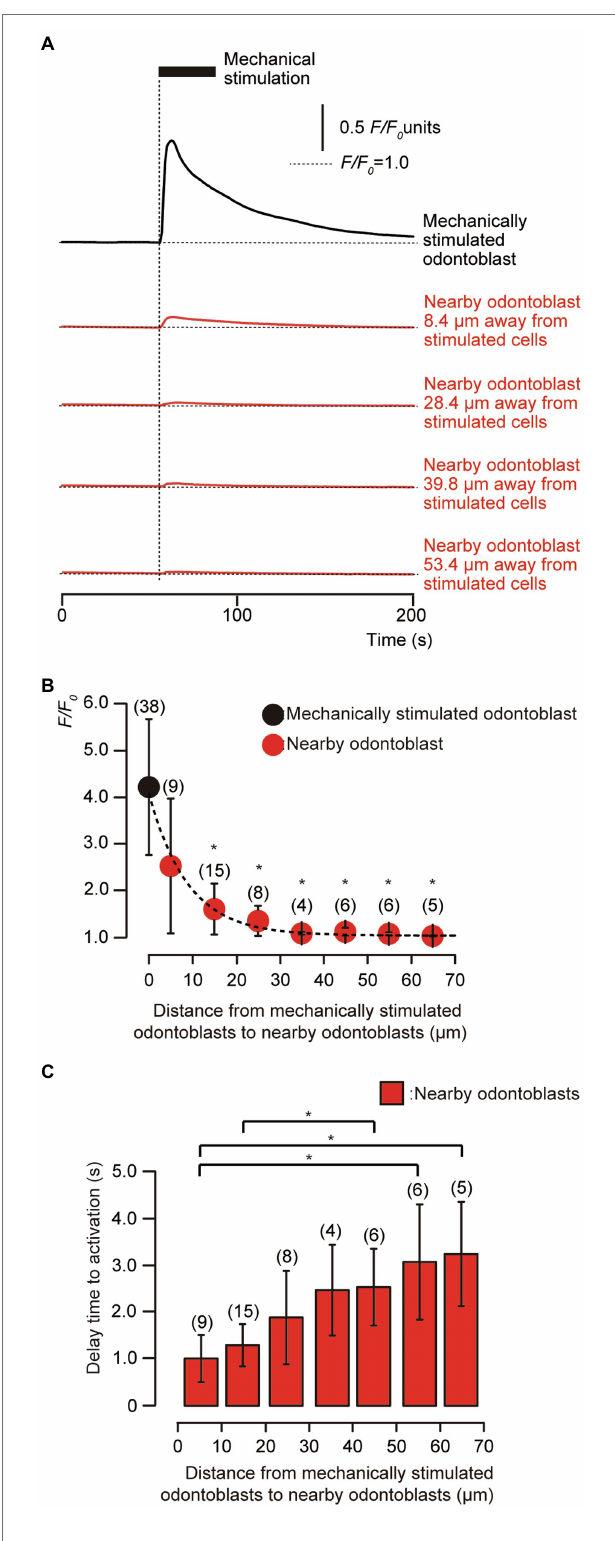
FIGURE 2 | Transient [Ca 2+ ] i increases in mechanical-stimulated human odontoblast and neighboring human odontoblasts to the stimulated cells. (A) Representative traces indicating transiently increased [Ca 2+ ] i from